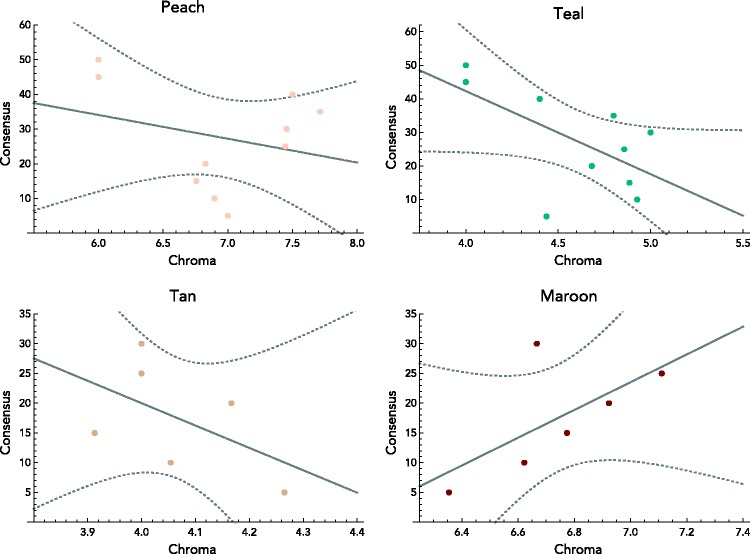
Plots of linear models with chroma as predictor of consensus, for the four most frequent non-BCTs. Dotted lines indicate 95% confidence bands.